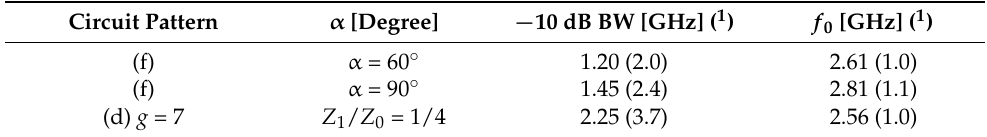
Figure 10. Measured | S 21 | and | S 11 | results of rectangular stubs of Z 1 / Z 0 = 1/4 with a series inductance g = 7 mm, as shown in Figure 5d, compared with two radial stubs. Table 3. Stop bandwidth in the case of radial stubs.